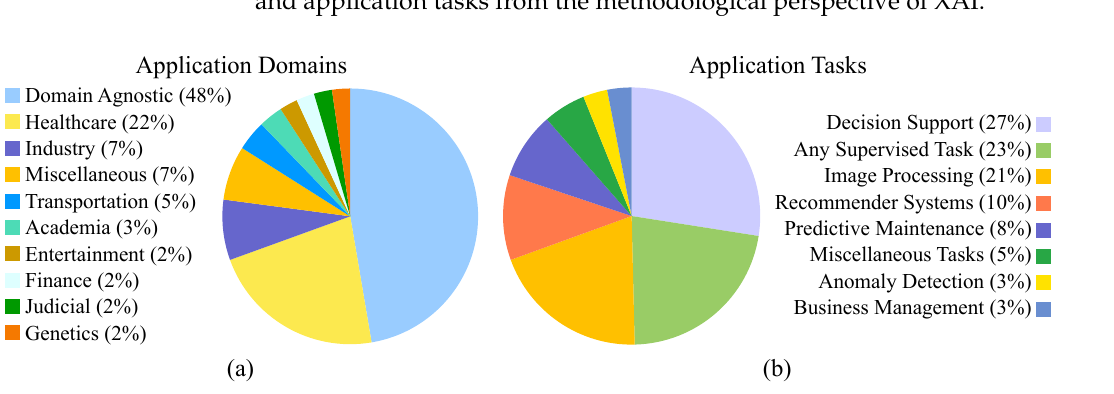
Figure 2. Percentage of the selected articles on different XAI methods for different application ( a ) domains and ( b )